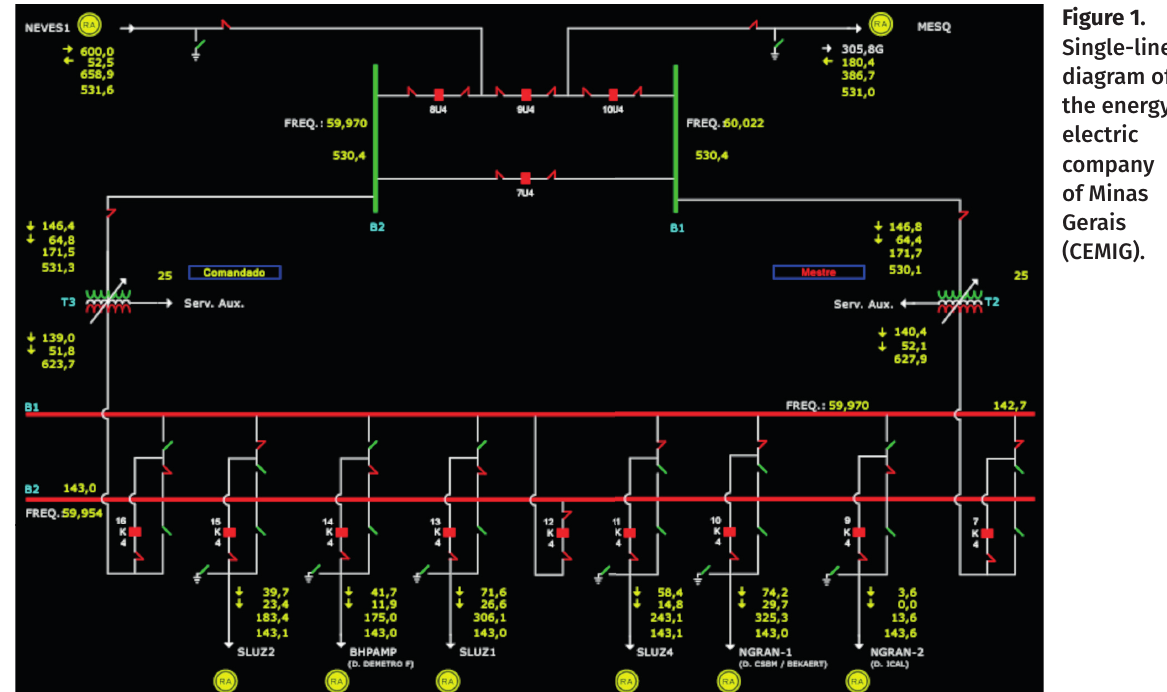
Figure 1. Single-line diagram of the energy